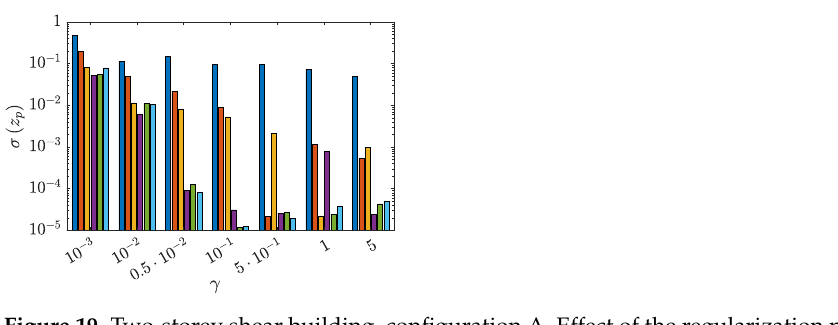
Figure 19. Two-storey shear building, configuration A. Effect of the regularization parameter γ on the value of the variance of each latent variable in z , evaluated on both the training and test sets for P max = 6.